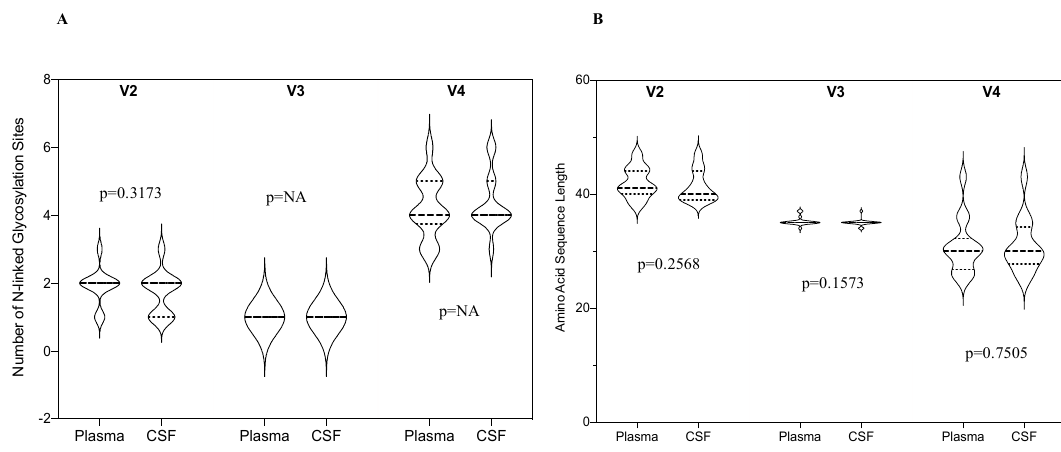
Figure 4. ( a ) A violin plot showing the median number of N-linked glycosylation sites in HIV-1 env V2, V3 and V4 loops in the CSF and plasma; ( b ) A violin plot showing amino acid sequence length in HIV-1 env V2, V3 and V4 loops in the CSF and plasma.